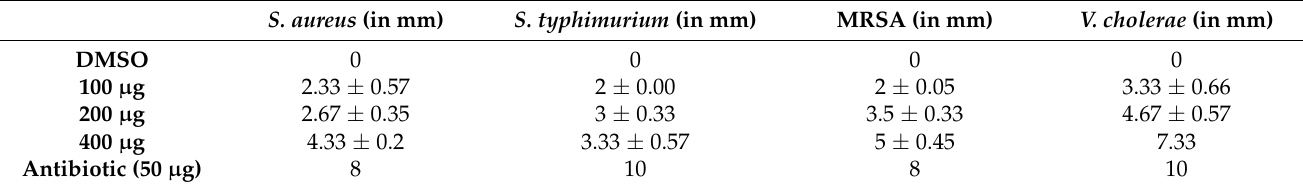
Table 2. Antibacterial activity (zone of inhibition) of CPEF02 methanolic colourant against bacterial pathogens (measured in mm).